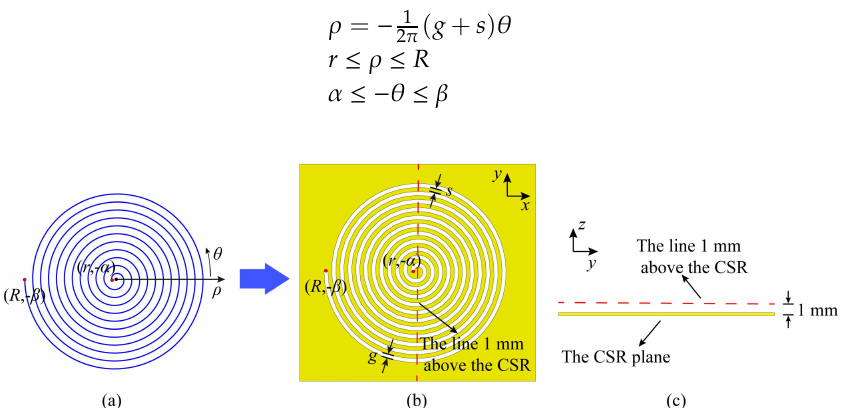
Figure 1. ( a ) The spiral in the polar coordinate; ( b ) The dimensions of CSR and the red dashed line 1 mm above the CSR; ( c ) The side view of the CSR and the red dashed line.